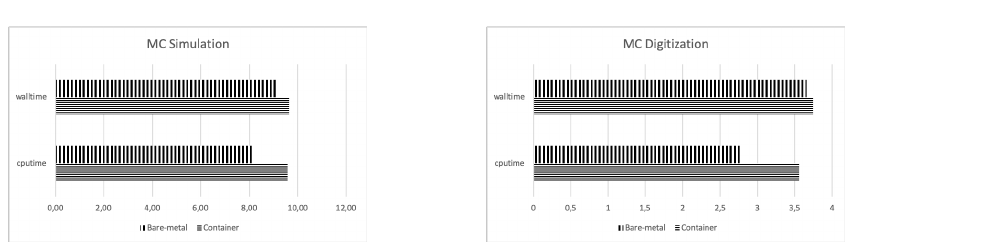
Figure 5. Timing comparison for simulation test.